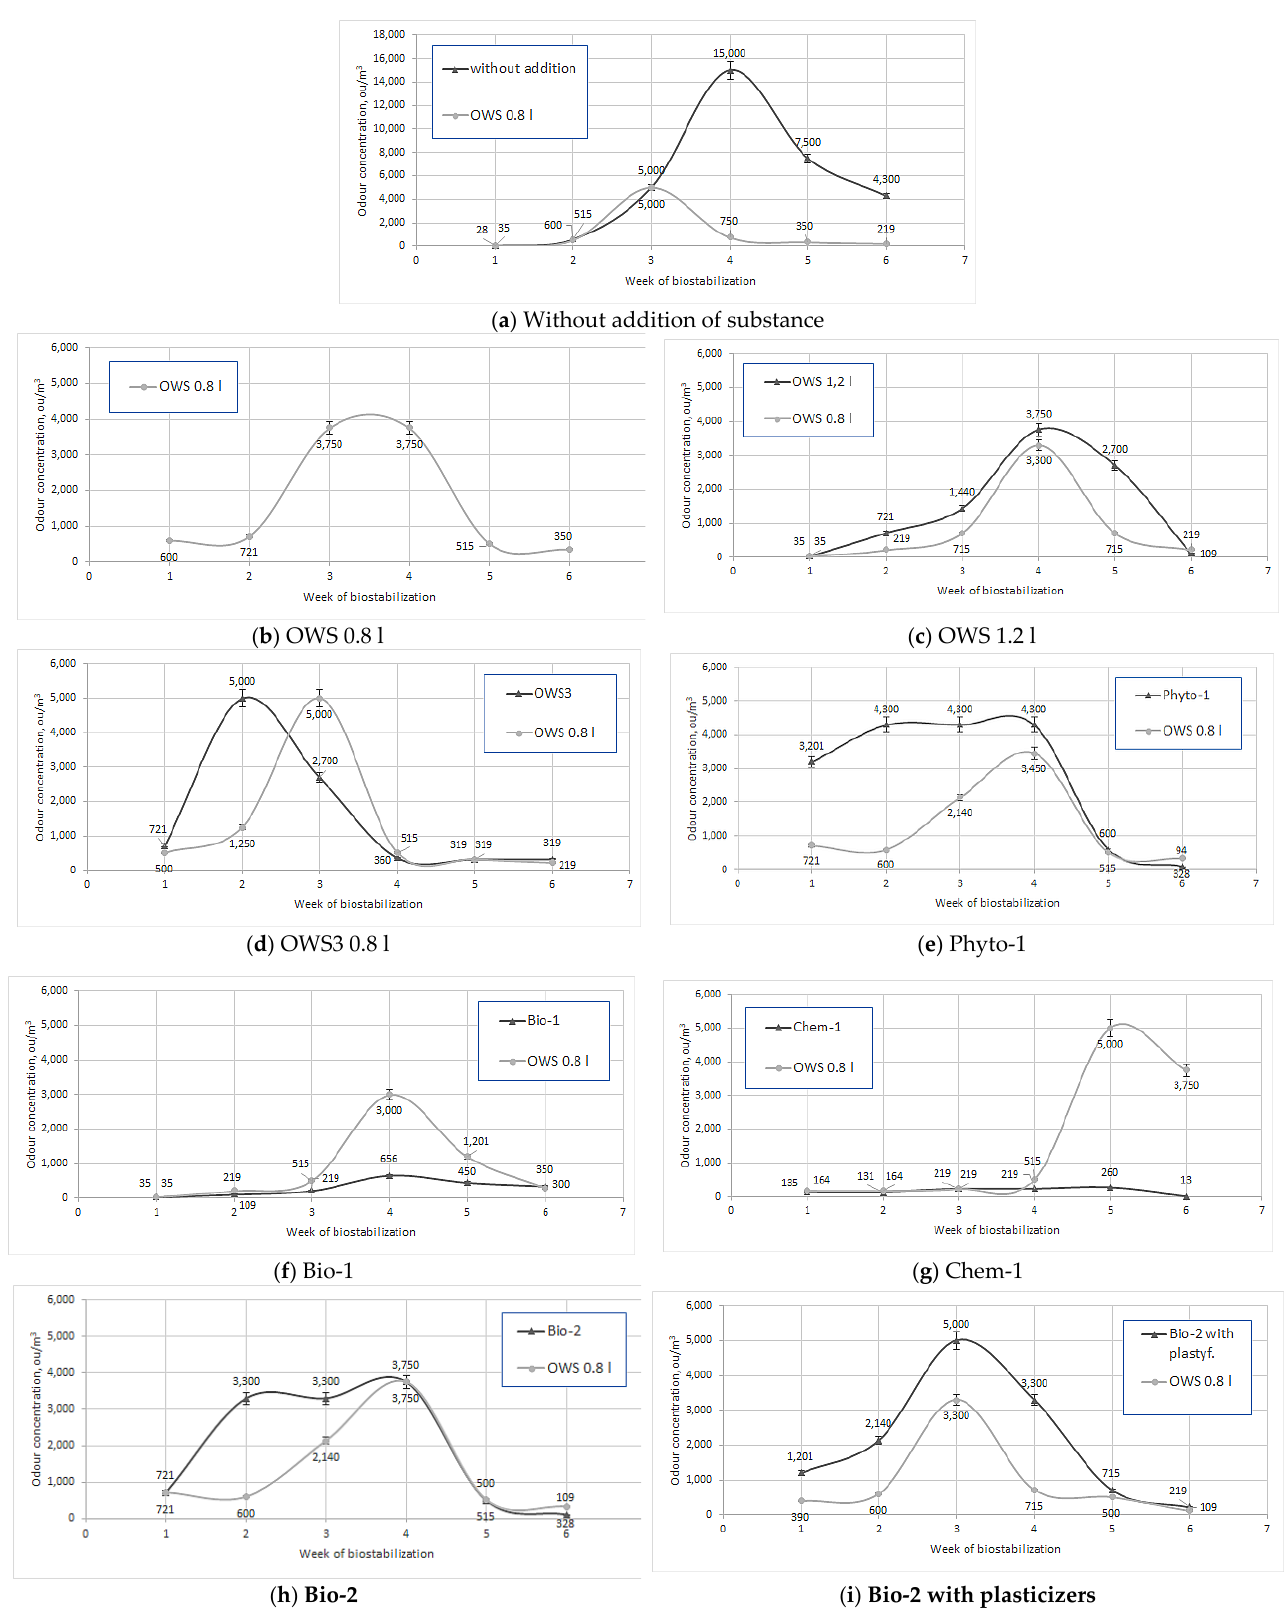
Figure 2. The dependence of odor concentration on the week of biostabilization in the variants under consideration. The highest odor concentration values were recorded, in most cases, during the third or fourth week of the process. For OWS3 0.8 L, odor concentration maximum occurred at the second week, while for Chem 1, it occurred at the fifth week. During the first weeks of waste stabilization with Chem-1, odor concentrations remained at 135–219 ou/m 3 . In the fifth week, the concentration increased to 5000 ou/m 3 and there was a rapid intensifi- cation of the processes and emission of odorogenous compounds. This was because the inoculation, which was a mixture of nitrogenous compounds, slowed down the biodeg- radation processes of the waste in the test pile. For the windrows inoculated with Bio-2 and Bio-2 with plasticizers, the maximum odor concentration was observed at the fourth and third weeks, respectively: It was 3750 ou/m 3 and 5000 ou/m 3 . The addition of plasti- cizers caused a significant intensification of odorogenous emissions already in the first weeks of biostabilization. Additionally, the odor in this pile was very pungent: Acetone was smelled in the pile for six weeks. Figure 3 shows the dependence of loss on ignition and total organic carbon on the week of biostabilization. ( a ) Without addition of substance